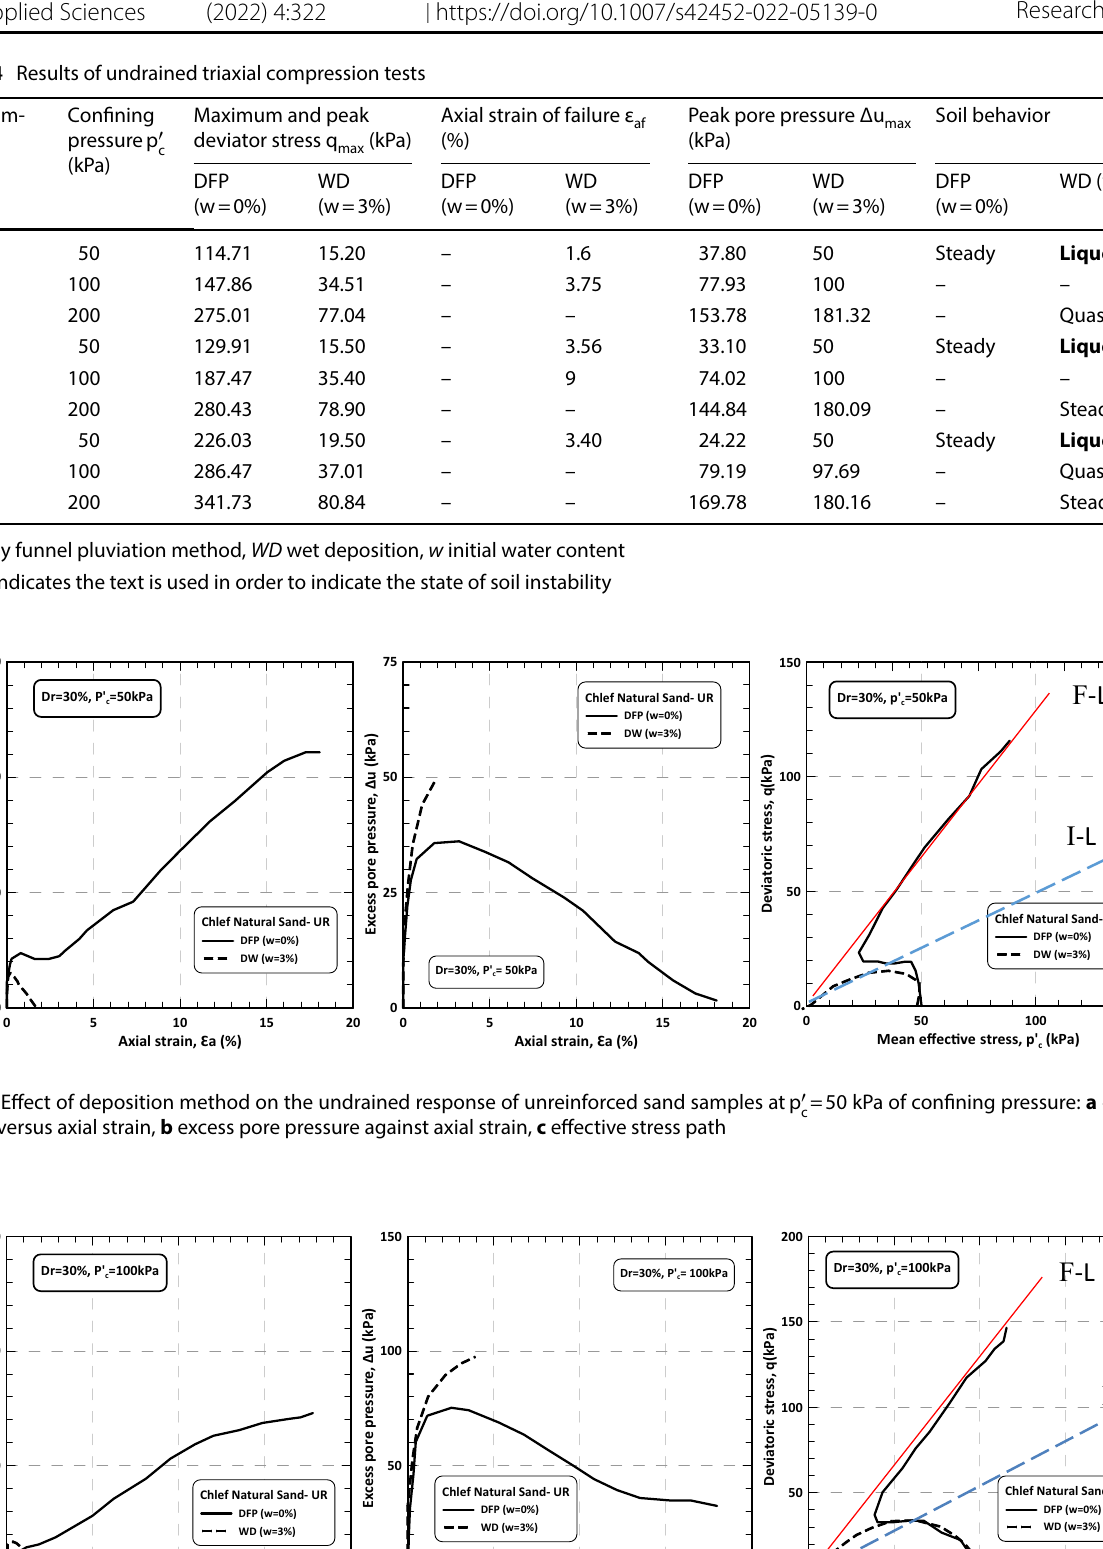
= 100 kPa of confining pressure: a deviator c